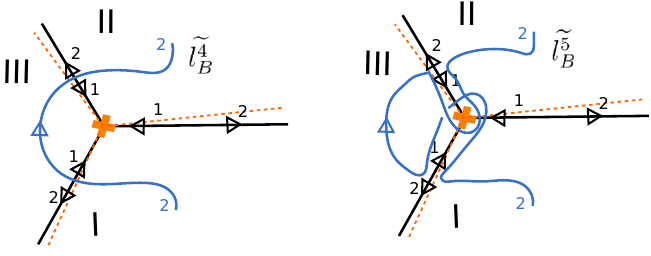
Figure 64 . Three lifts of l A and l B with matching contributions.